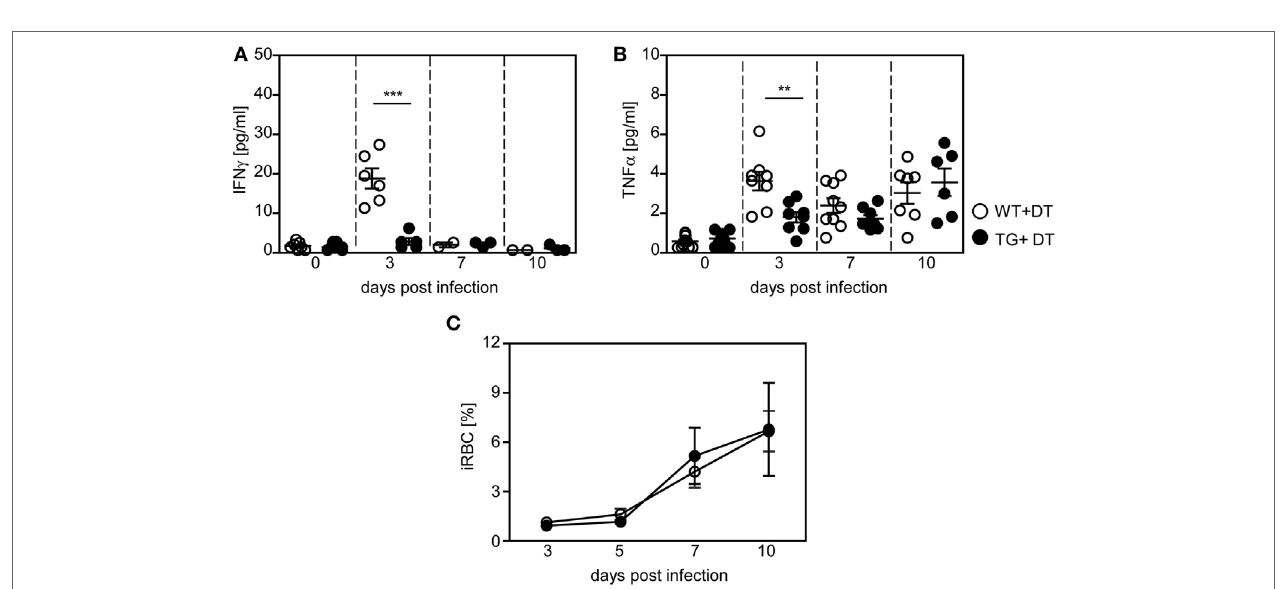
FigUre 5 | Decreased production of pro-inflammatory cytokines in long-term dendritic cell-depleted Plasmodium yoelii- infected mice. Diphtheria toxin (DT)-treated ( + DT) RosaiDTR/CD11c-cre (TG) and RosaiDTR wild-type (WT) mice were infected with P. yoelii for 3, 7, and 10 days. At indicated time points, the amount of (a) IFN- γ and (B) TNF- α was determined in the serum by Luminex technology. (c) Parasitemia was determined at days 3, 5, 7, and 10 by Giemsa-staining. Results from two to three independent experiments with (a,B) n = 6–13 mice per time point and (c) n = 43–47 mice in total were summarized as mean ± SEM. Student’s t -test and One-Way ANOVA (c) was used for statistical analysis. * p < 0.01; *** p <